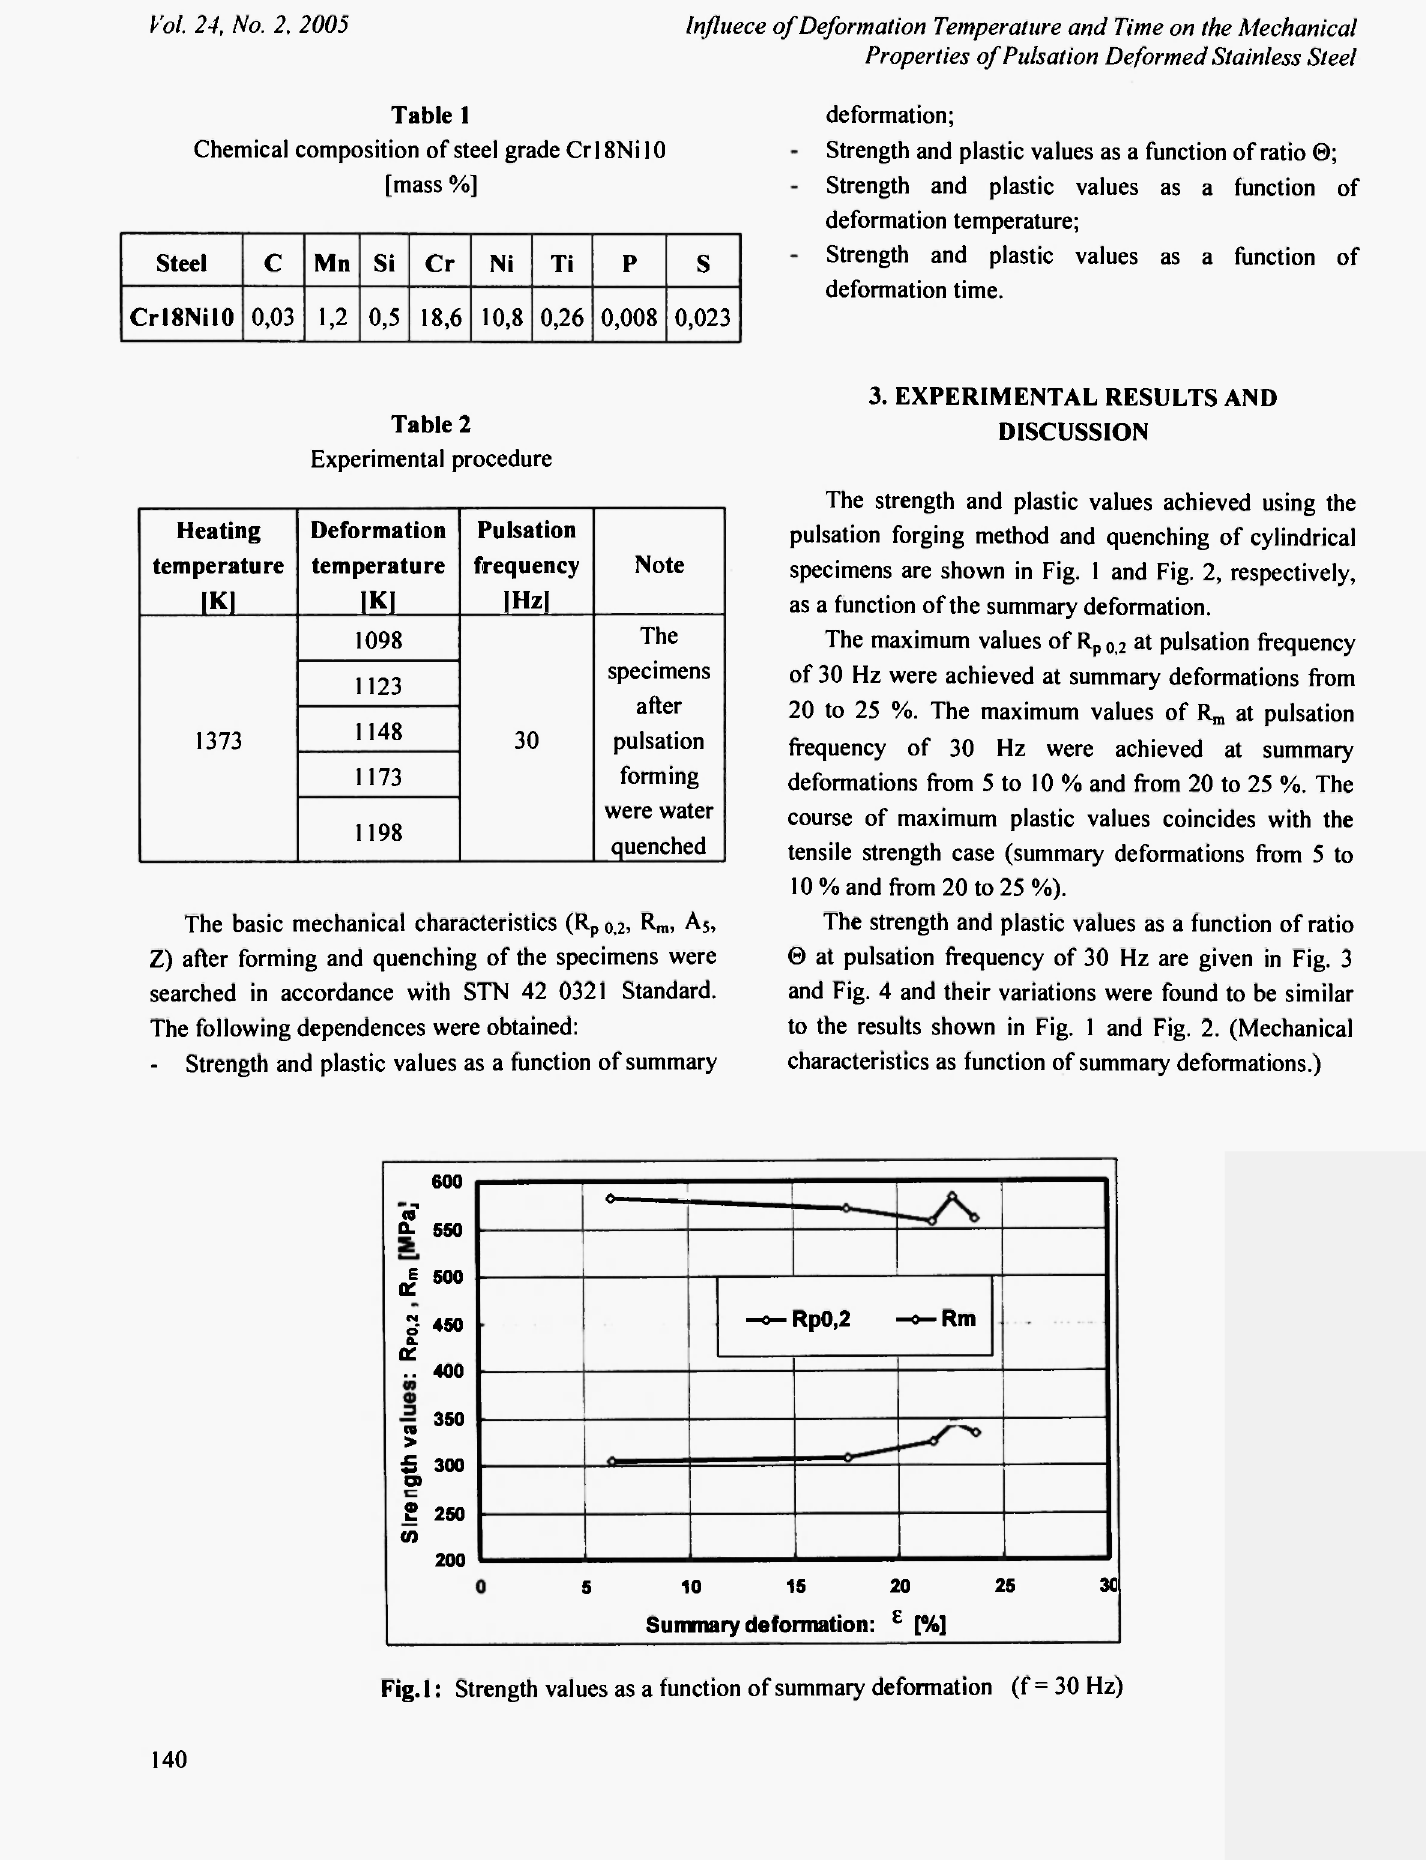
Experimental procedure